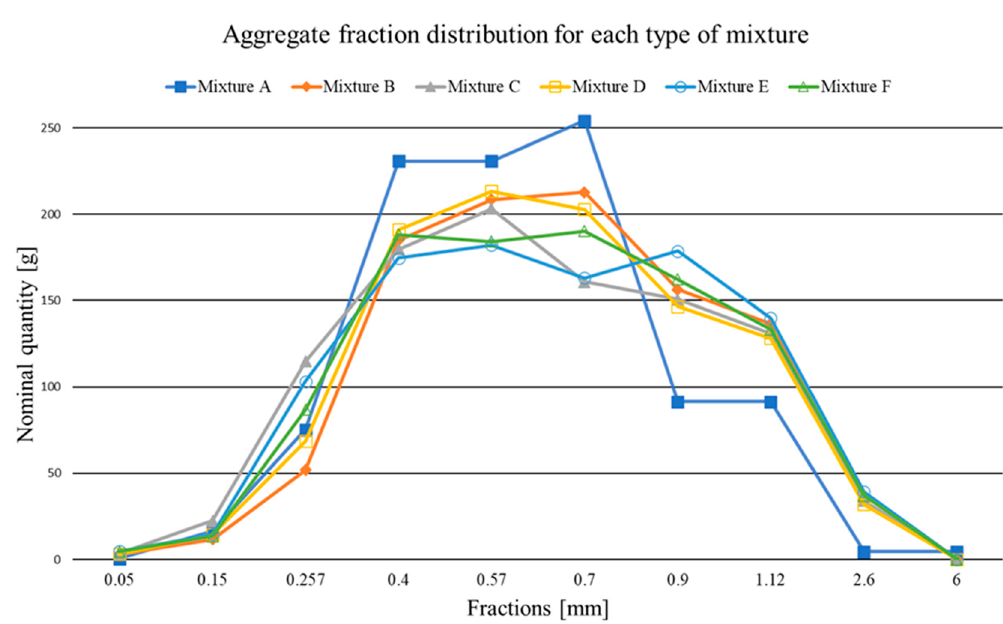
Figure 1. Aggregate fraction distribution for individual mixtures. The x-axis shows the mean values of the fraction intervals reported by the manufacturer.